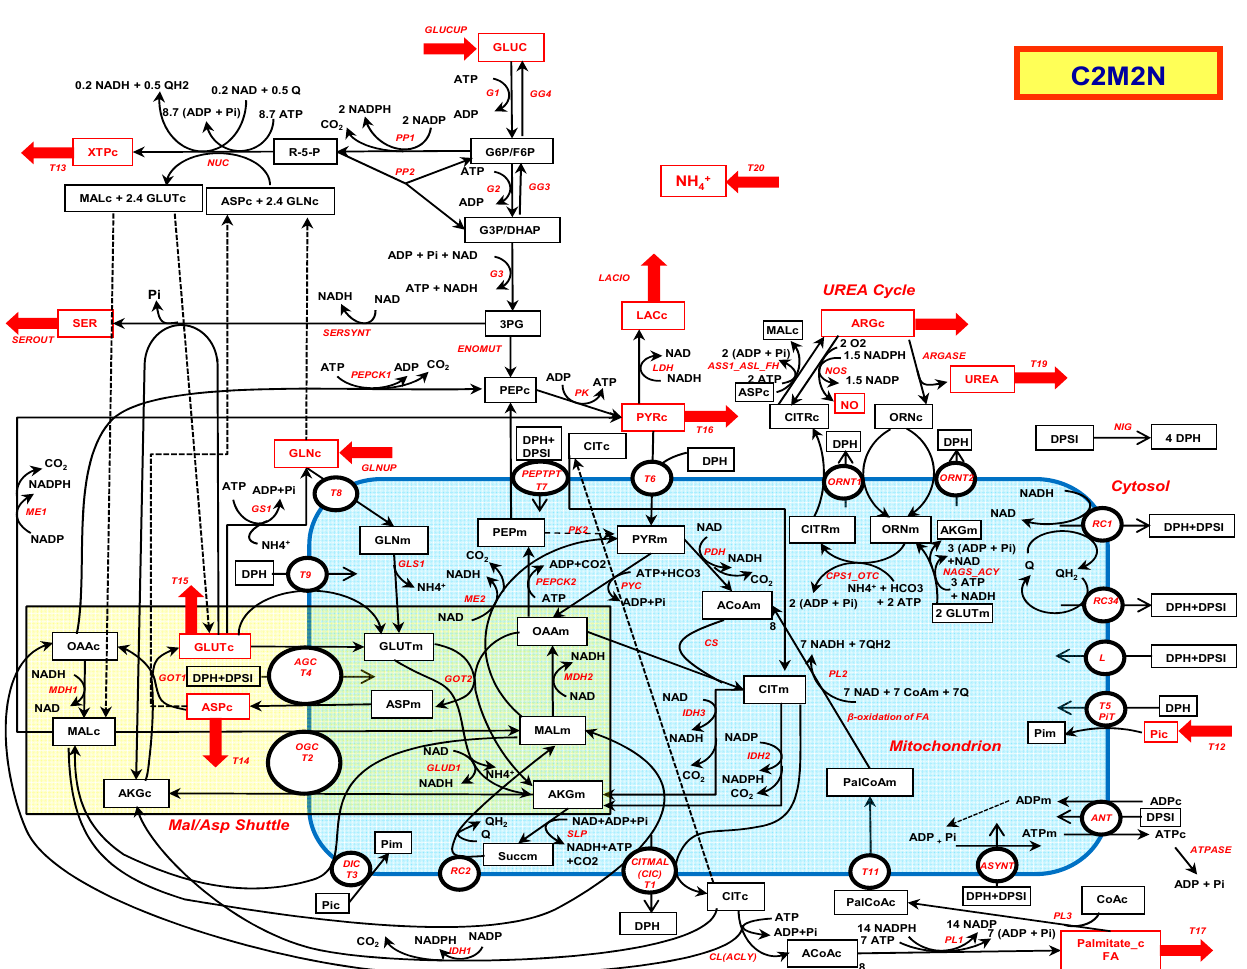
Figure 1. The central carbon metabolic with nitrogen model (C2M2N). Possible entries and outputs are indicated by red arrows. The corresponding metabolites are in red. The abbreviated names of the reactions are indicated in red italic along the arrows of the reactions. The mitochondrion is in blue and the malate–aspartate shuttle in light brown. Dotted lines link identical metabolites duplicated for the sake of presentation.